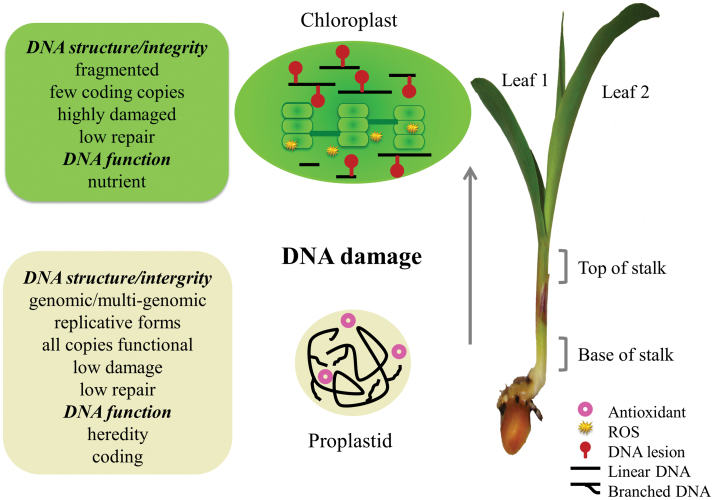
Changes in orgDNA during maize development. Recombination-dependent replication of orgDNA in the basal meristem produces branched, multigenomic chromosomes in proplastids and mitochondria (not depicted). DNA-damaging oxidative stress is minimized, requiring little repair, by maintaining hypoxia, antioxidants, and no ROS-generating photosynthesis or respiration. Early in leaf development, orgDNA damage occurs due to ROS generated in photosynthesis, respiration, and oxidation of pigments and lipids. Later, when the damage level exceeds the repair capacity, orgDNA is fragmented and no longer functions in coding or heredity, mitochondria switch from respiration to photorespiration, and DNA copy number declines faster for mitochondria than for chloroplasts.